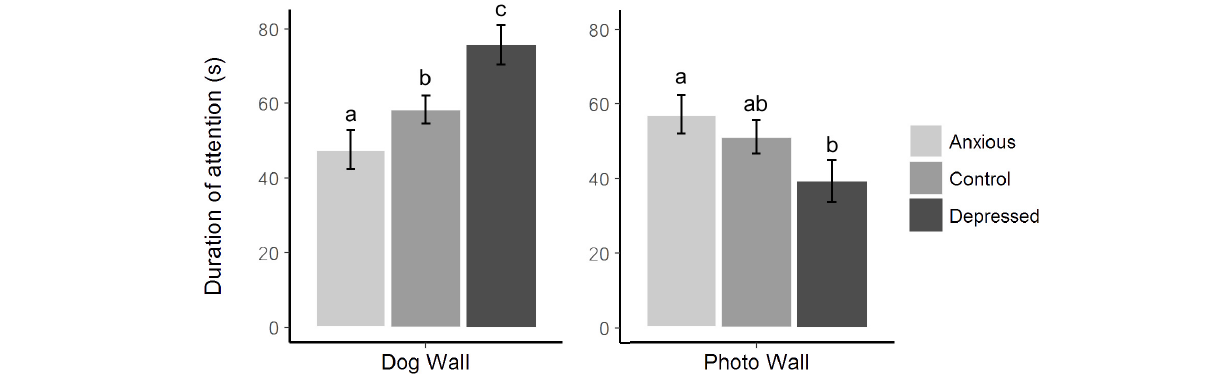
FIGURE 3 | Mean ± SEM time spent looking toward the dog wall versus the photo wall for each treatment group during attention bias testing. Different letters represent significant differences between treatment groups within each section of the graph as determined using post hoc